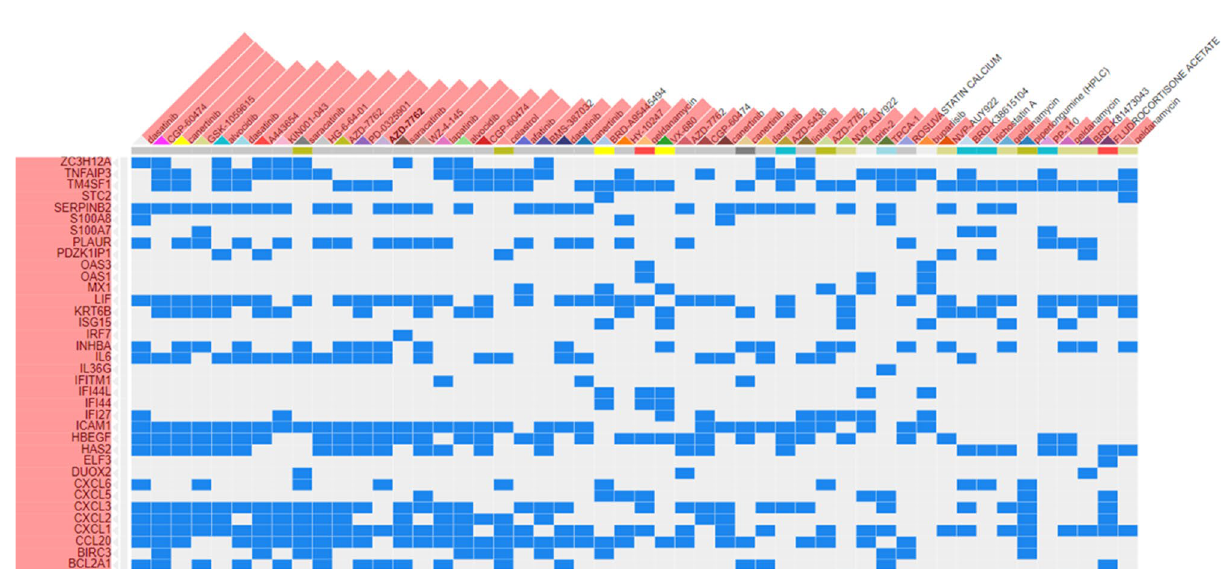
Figure 6. SARS-CoV-2 transcriptome-based drug prediction. L1000CDS2 visualization of drug-induced signature. Significantly upregulated top 50 genes found in at least two datasets were used as input dataset. Blue square represents drug that may inhibit